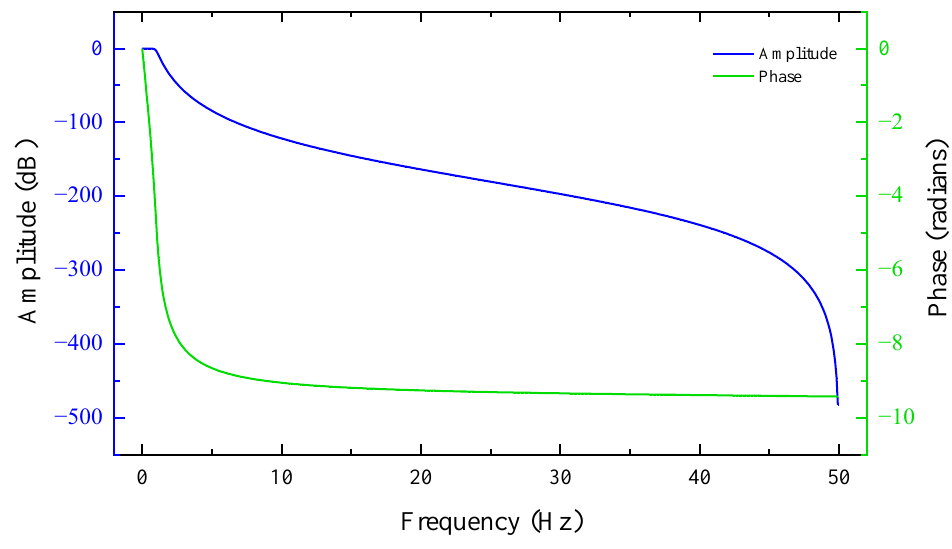
Figure 6. Butterworth Low-Pass Filter Frequency Response and Phase Frequency